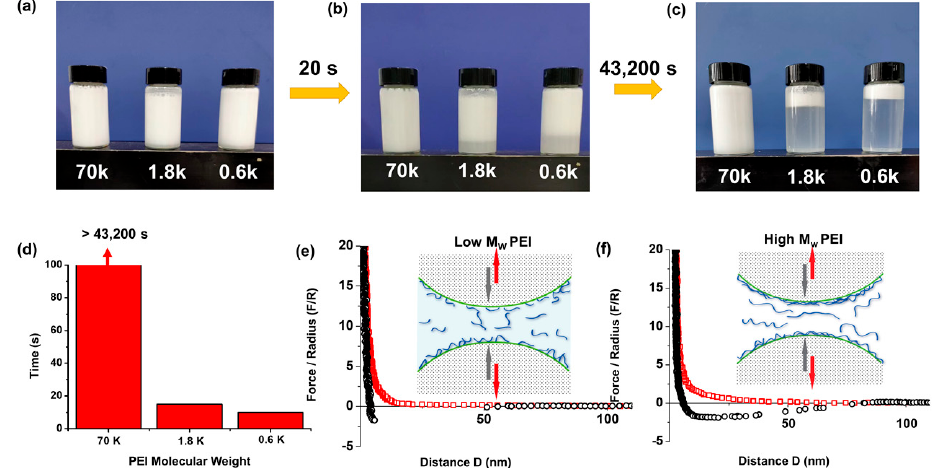
Figure 4. The effect of PEI molecular weight on the stability of HP suspensions. ( a – c ) Photos of SiO 2 HPs modified with PEI polymer (molecule weight Mw = 600, 1800, and 70,000). ( d ) Stabilization time of SiO 2 @PEI suspensions prepared via PEI 600, 1800, and 70,000, respectively. ( e , f ) Force–distance profiles of mica–mica surfaces after injecting PEI at high ( e ) or low ( f ) molecular weights.